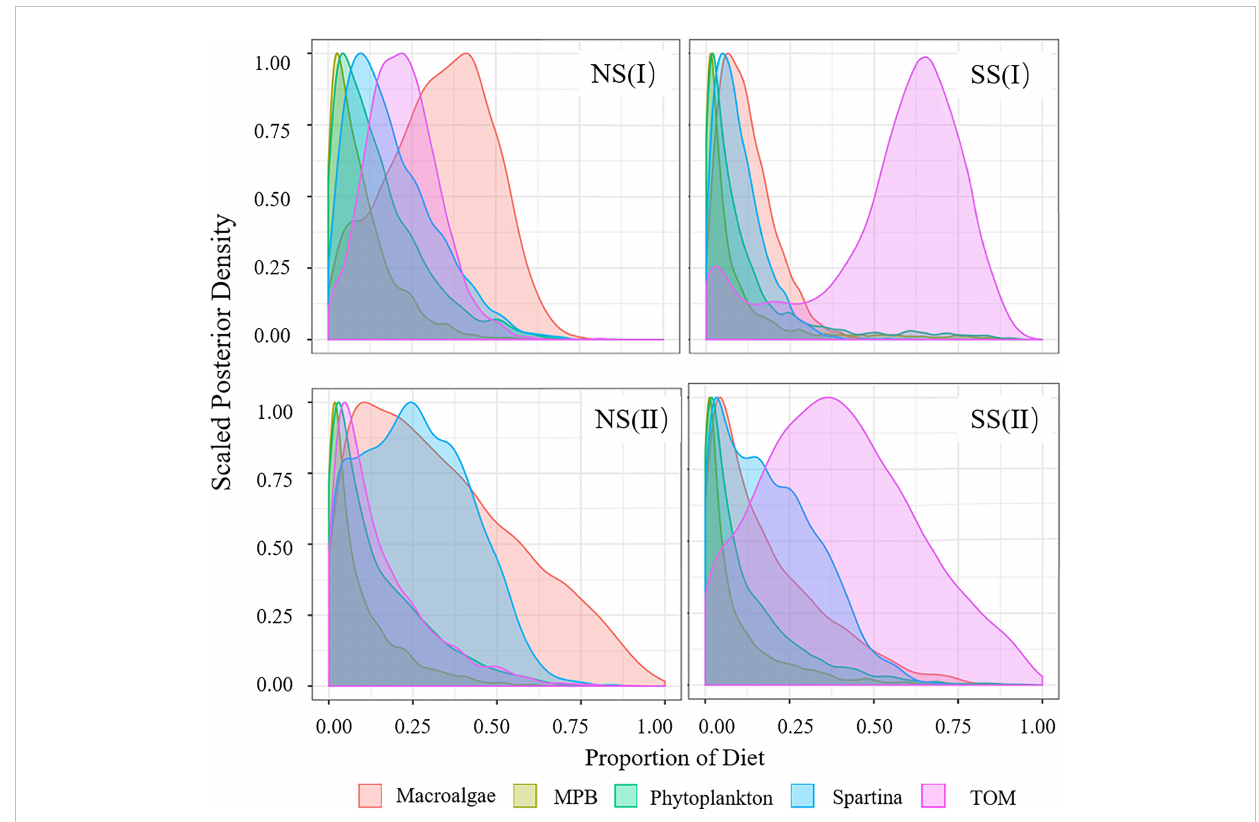
FIGURE 6 Diet Proportion of invertebrates. (I) Flood season; (II) Non- fl ood season; (NS) Northern shore; (SS) Southern